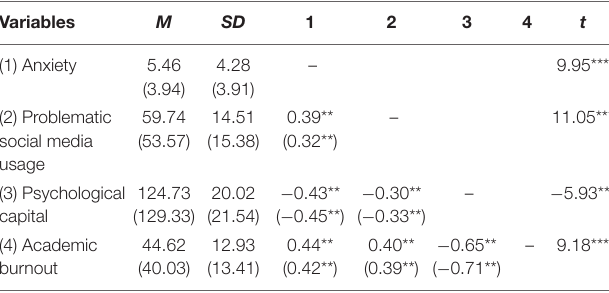
TABLE 1 | Means, standard deviations, bivariate correlations, and t -test of variables.